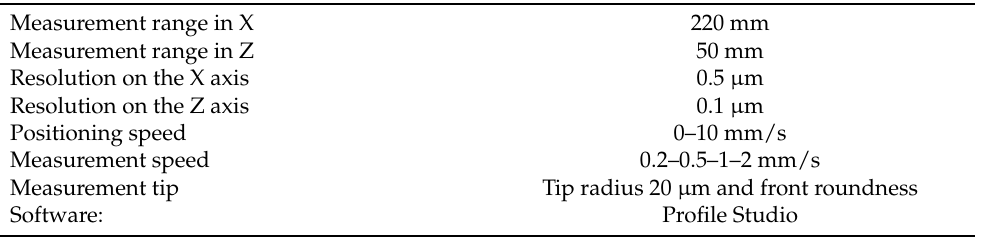
Table 6. Profilometer technical specifications.